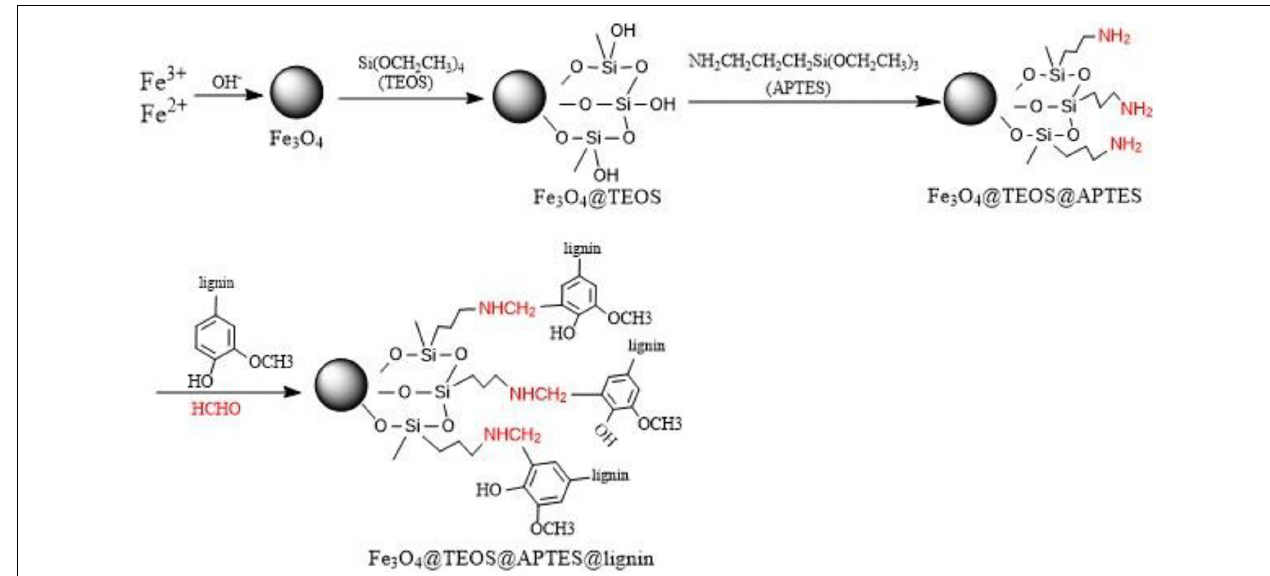
FIGURE 1 | Mannich reaction synthesis diagram. TEOS, tetraethyl orthosilicate; APTES, 3-aminopropyltriethoxysilane.